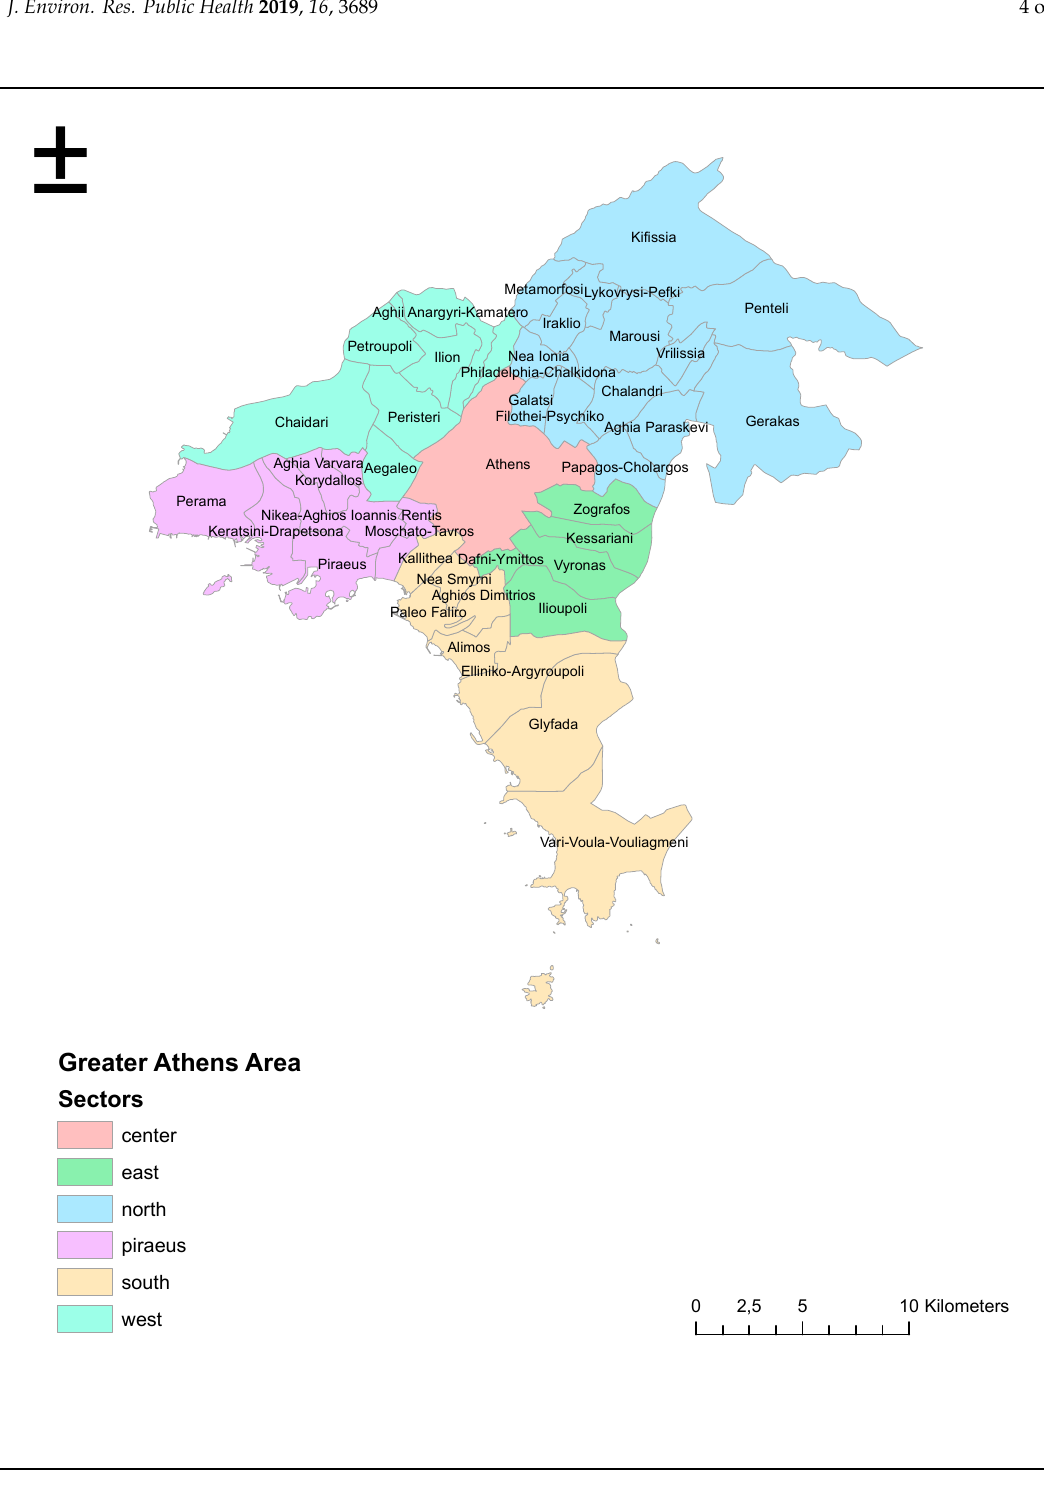
Figure1. ( A )MapofGreeceandtheAthensareashowingthesubdivisionintosixsectors. ( B )TheGreater Figure 1. ( A ) Map of Greece and the Athens area showing the subdivision into six sectors. ( B )The Athens area with the subdivision into six Sectors and 42 Greater Athens area with the subdivision into six Sectors and 42 Municipalities.